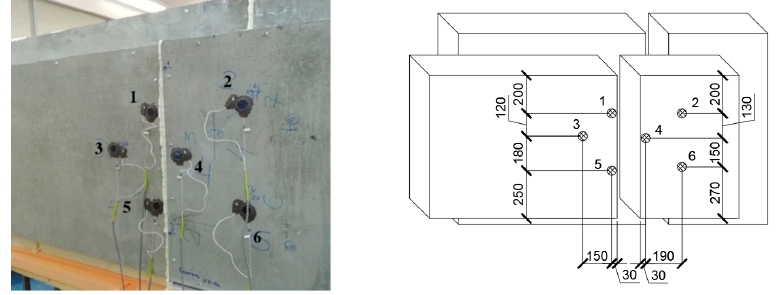
Figure 12. Sample No. 3 with installed thermal and temperature sensors. Based on the data obtained, the most temperature-stabilized estimated time intervals were selected, and graphs of temperature on the specimen No. 3 surface versus time and of heat flow versus time were plotted (see Figures 13 and 14).